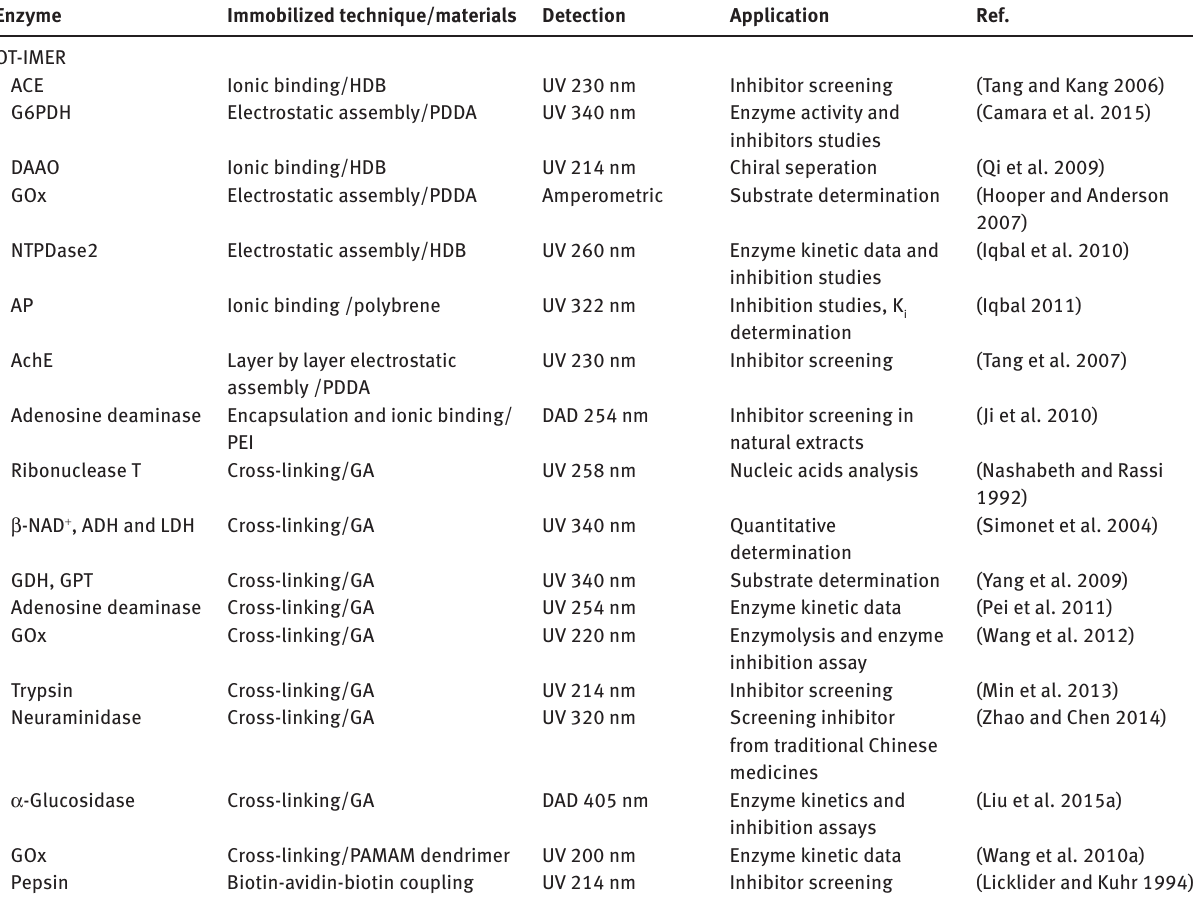
Table 2: Summary of studies using OT-IMER, monolithic IMER, and packed capillary IMER for on-line enzyme assays based CE.